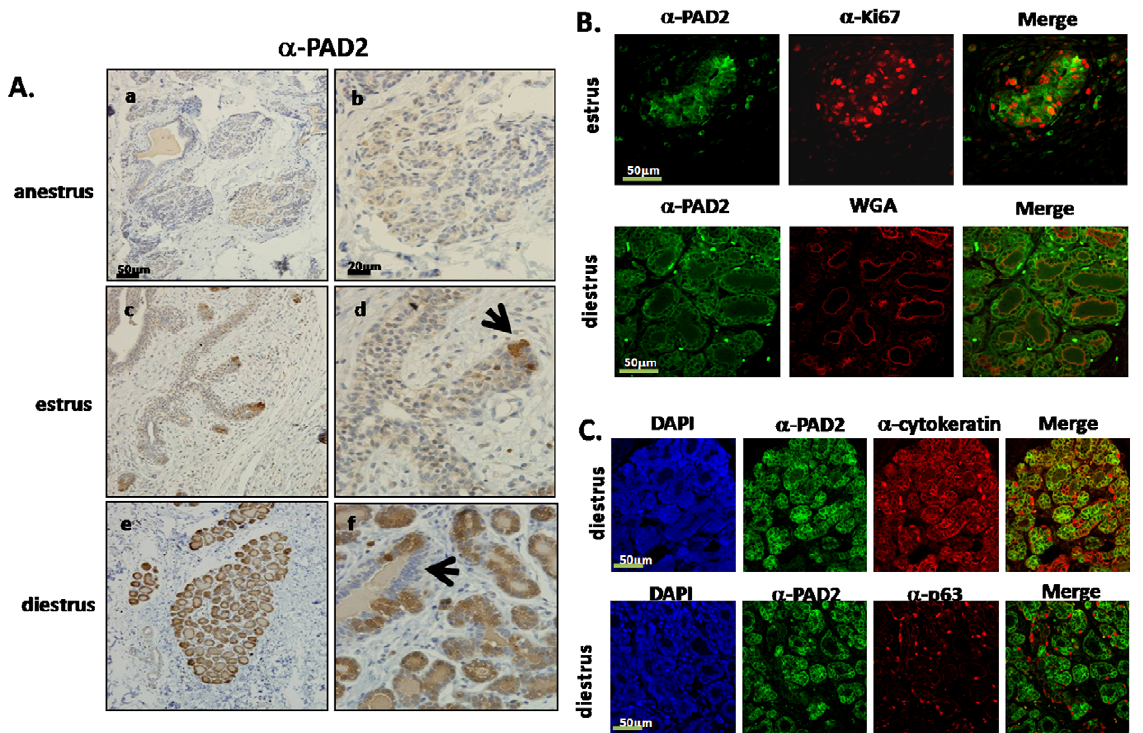
Figure 1. PAD2 expression in canine mammary tissue. (A) PAD2 is expressed in the canine mammary gland in an estrous cycle dependant fashion with the highest expression in alveolar unit epithelium during late diestrus. Anestrus (a 200 6 , b 630 6 ), estrus/early diestrus (c 200 6 , d 630 6 ), and late diestrus (e 200 6 , f 630 6 ) mammary tissue sections were probed with anti-PAD2 antibody or equal concentration of rabbit IgG as a control (see Supplemental Figure 1A) and counterstained with hematoxylin. Arrow in estrus/early diestrus depicts occasional alveolar end units expressing PAD2. Arrow in diestrus depicts lack of PAD2 epithelial staining in ductule. (B) PAD2 (green fluorescent signal) is first detected in estrus/early diestrus, a time of high cellular proliferation, but PAD2 is widely expressed in late diestrus during active lactation. In estrus the red fluorescent signal represents the proliferation marker Ki67 (400 6 ), while in diestrus the red fluorescent signal is WGA (400 6 ) which stains the apical membrane of actively lactating mammary glands and all nuclei are stained with DAPI. (C) PAD2 expression is restricted to canine mammary luminal epithelial cells. PAD2 expression is shown as green fluorescent signal during anestrus and diestrus. In 3A, the red fluorescent signal represents cytokeratin, a marker for luminal epithelial cells, while in 3B the red signal is p63, a marker of myoepithelial cells, and all nuclei are stained with DAPI (400 6 ).